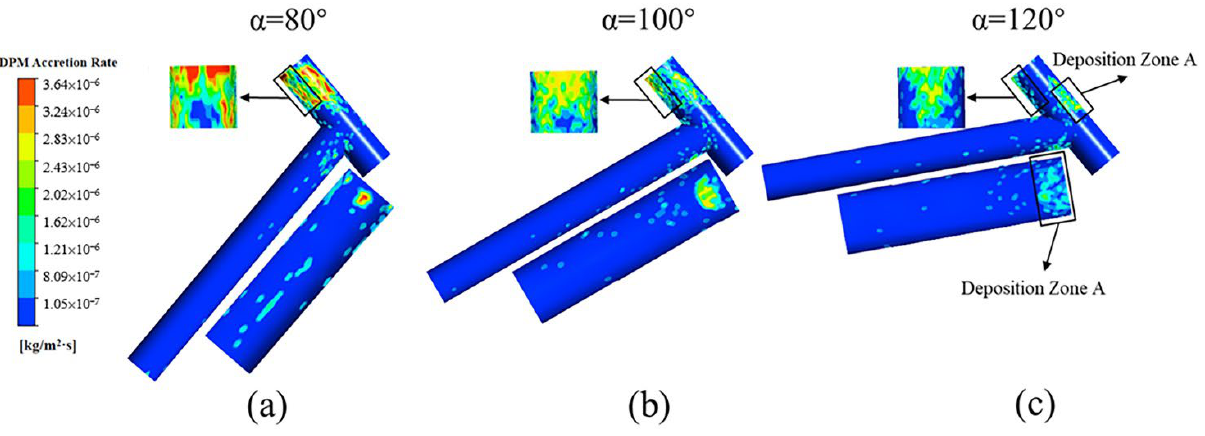
Figure 15. Distribution of particle deposition at various angle α. ( a ) α = 80°; ( b ) α = 100°; ( c ) α = 120°.